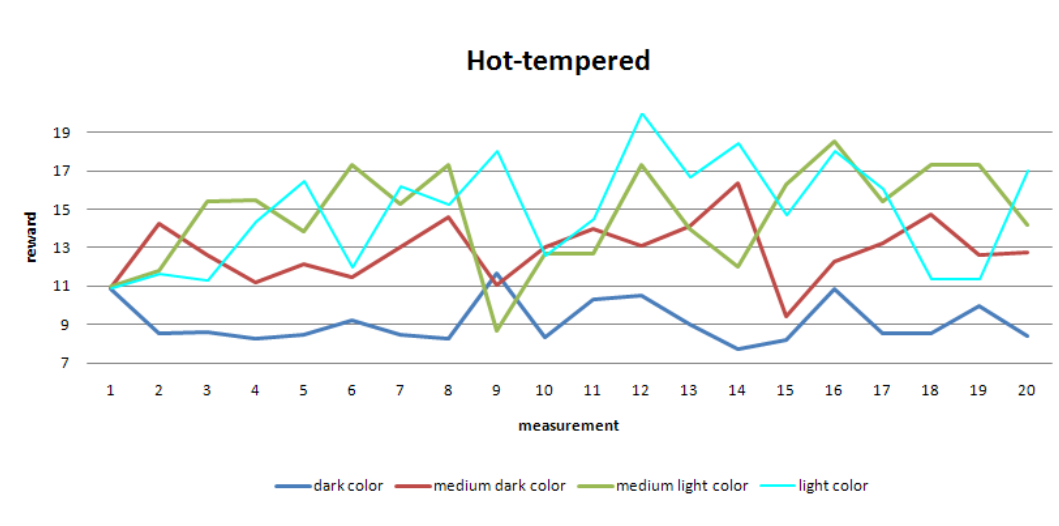
Figure 9. Performance of a robot with a higher randomness in its speed